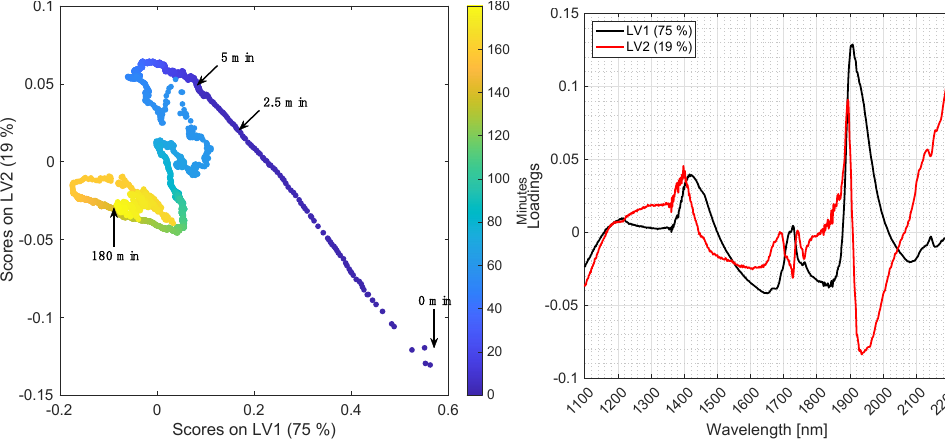
Figure 6. Left: PCA score plot of batch B using EMSC preprocessing and a measurement time window width of 60 s. Right: Loadings plot of LV1 and LV2.